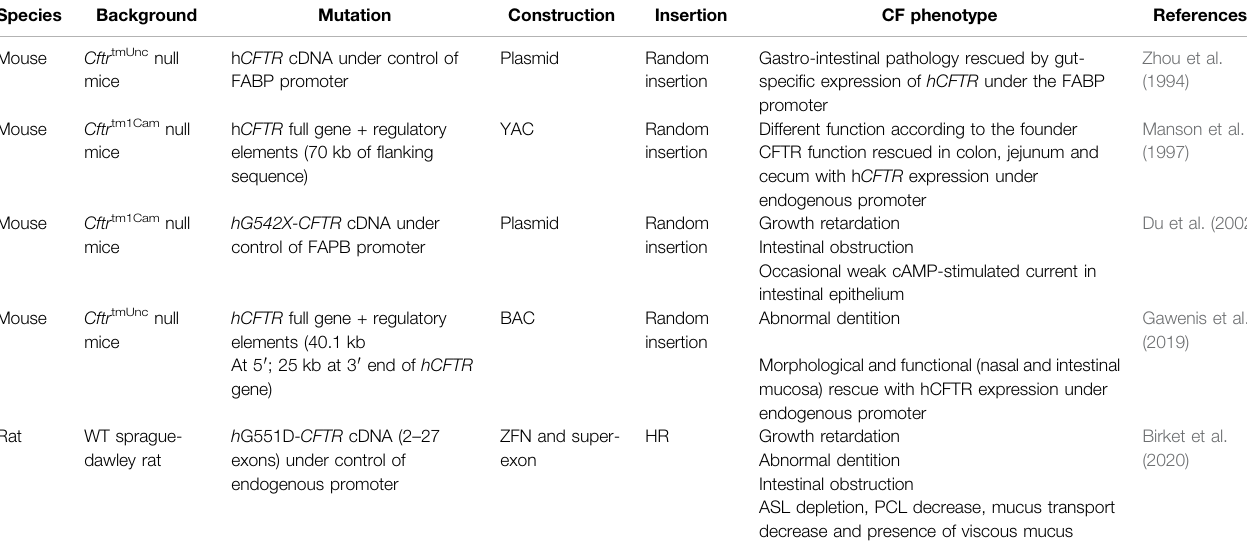
TABLE 2 | Introduction of human CFTR to generate humanized CFTR animal